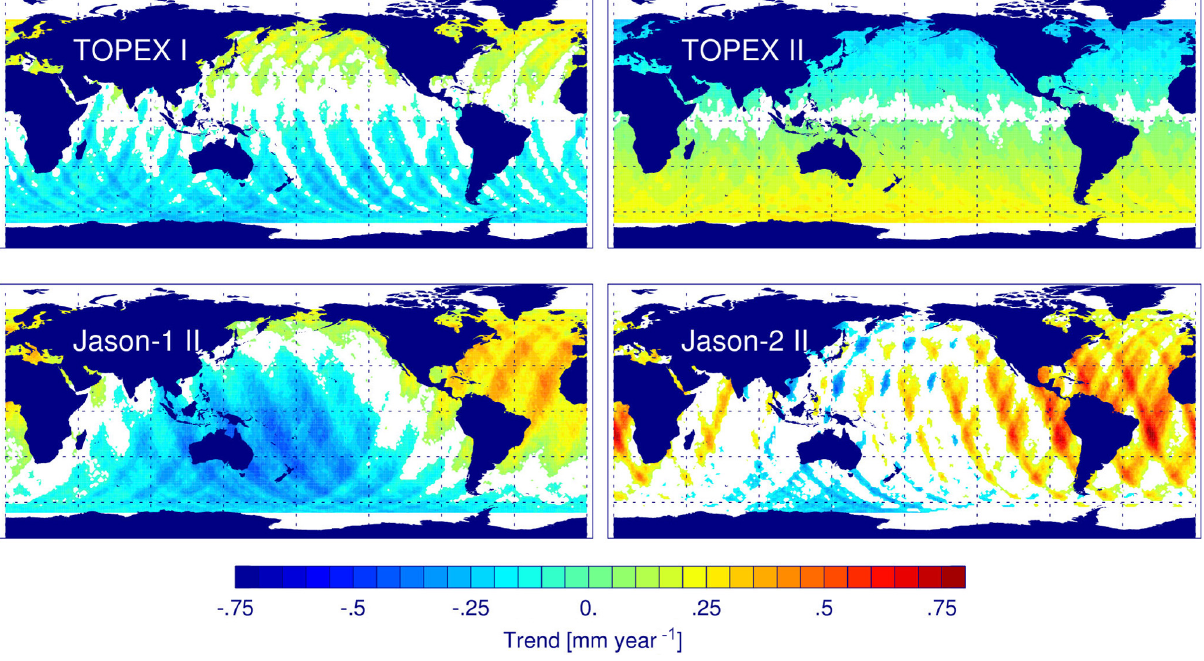
Figure 8. Trend differences in radial orbit components for VER11-VER13 for four periods. TOPEX I: April 1993–May 1997; TOPEX II: June 1997–September 2005; Jason-1 II: October 2007–February 2012; Jason-2 II: March 2012–April 2015. Regions with formal errors larger than the fitted value are masked out (white). The global mean trend difference is given in Table 7.